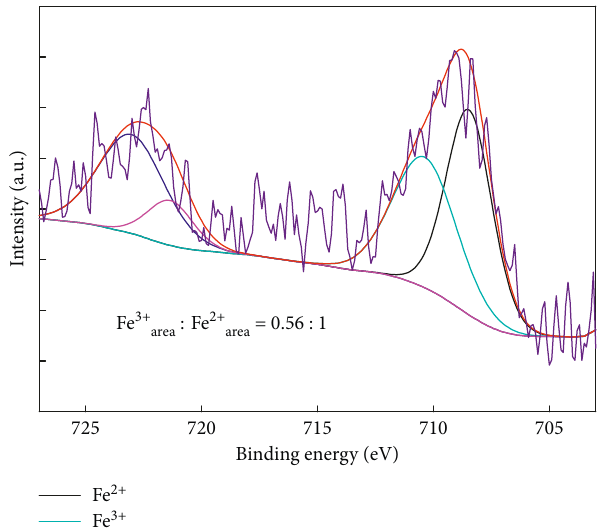
Figure 9: The XPS spectra of ceramics with 15% vanadium-titanium slags at the sintering temperature of 1100 °